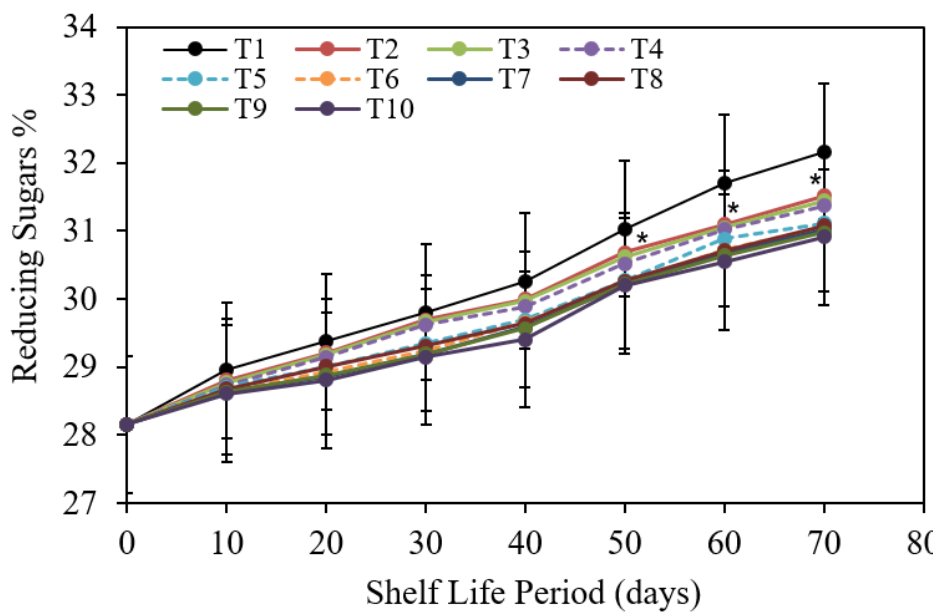
Figure 11. The impact of pre-harvest chitosan, chitosan nanoparticle, and CaCl 2 foliar spray treatments on reducing sugars of Barhi date fruits under cold storing for 70 d. Note that * sign denotes the significant differences between the control and edible coatings treatments, and T1, T2, T3, T4, T5, T6, T7, T8, T9, T10 are water (control), 1 g/L chitosan, 2 g/L chitosan, 3 g/L chitosan, 1 g/L chitosan nanoparticles, 2 g/L chitosan nanoparticles, and 3 g/L chitosan nanoparticles treatments, respectively.